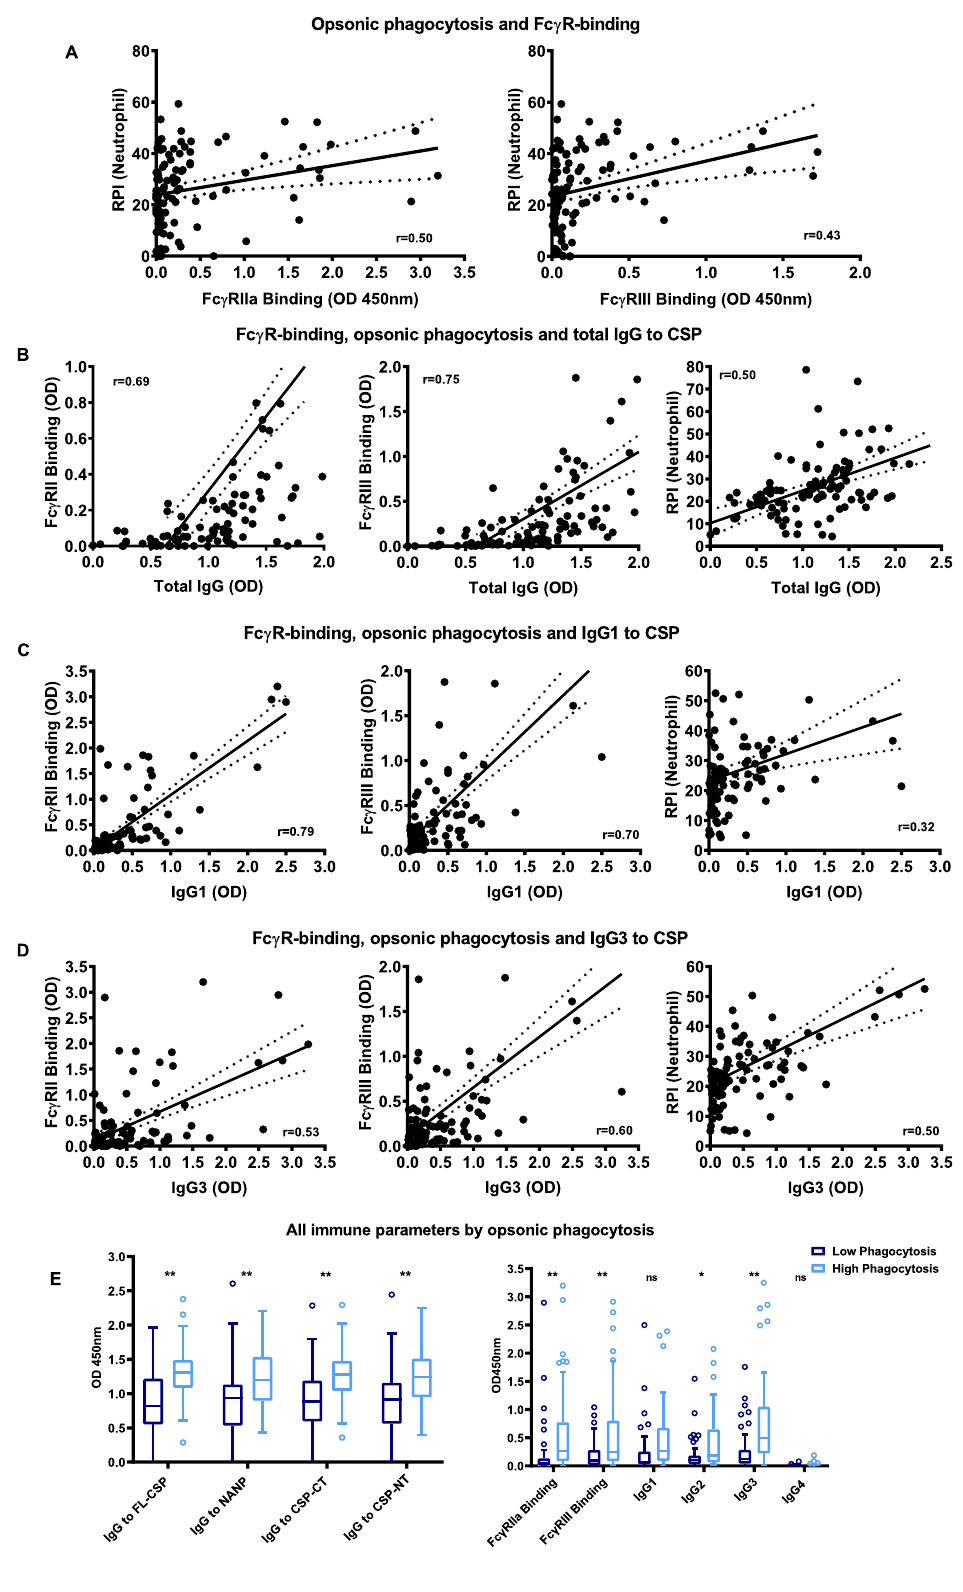
The protein was expressed in Pichia pastoris beginning at amino acid residue 50 and contains (NANP) 22 repeats and (NVPD) 4 repeats. The C-terminal region of CSP (CT) and a fusion of the N-terminal region and C-terminal region of CSP (N + C) were generated as recombinant proteins using HEK293F cells (purchased from Invitrogen, Australia). The N-terminal region of CSP (amino acid 19-104, NT) was generated as synthetic peptides and the central repeat region of CSP (NANP)